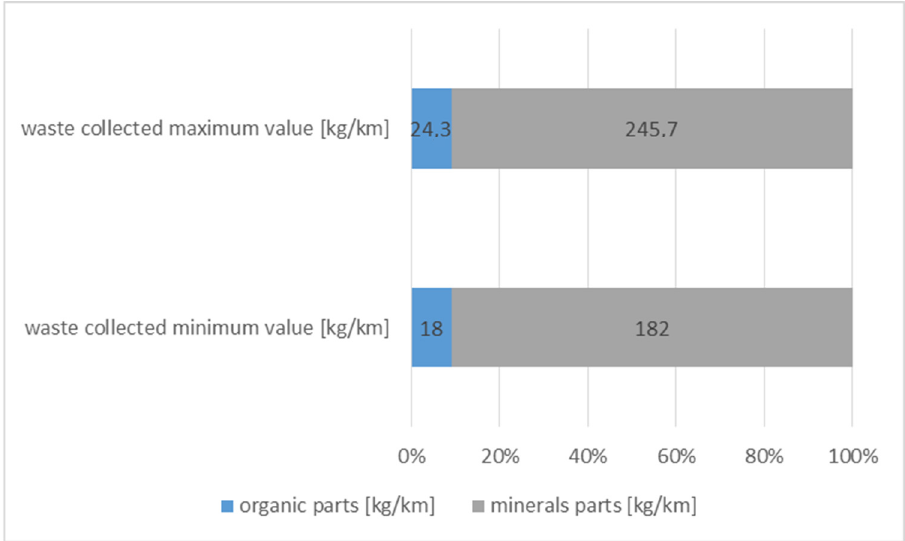
Figure 1. Maximum and minimum amounts of street cleaning waste collected, divided into organic and mineral components.